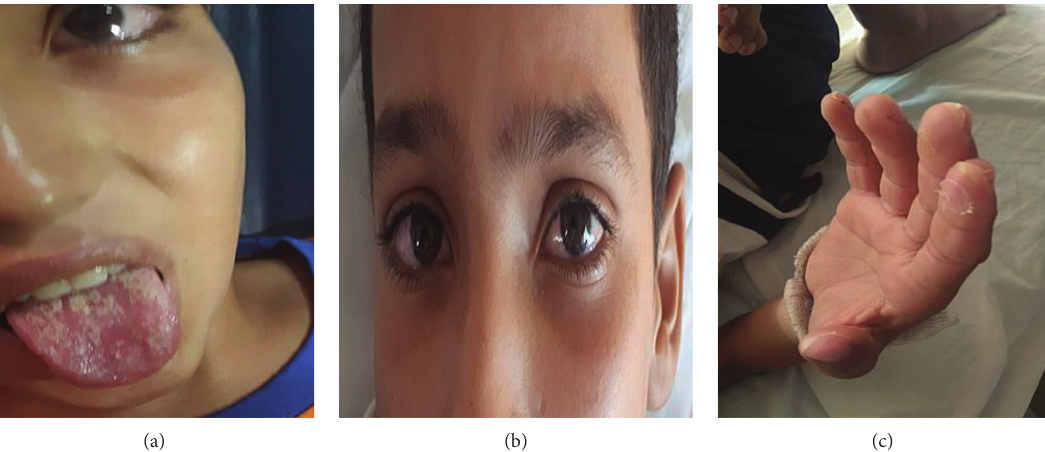
Figure 1: Clinical symptoms in our patient. (a) Coated tongue. (b) Bilateral ocular redness (uveitis). (c) Periungual desquamation.